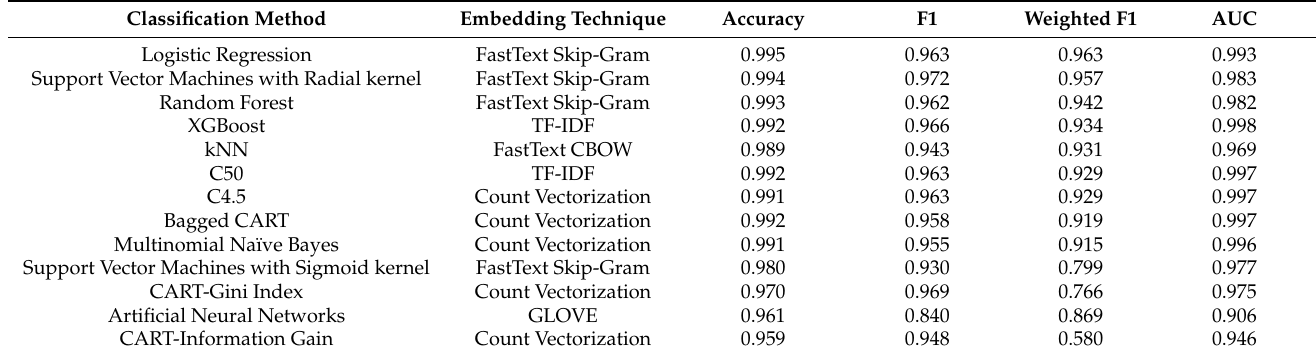
Table 7. Classification methods and embedding techniques with the highest weighted F1-scores.